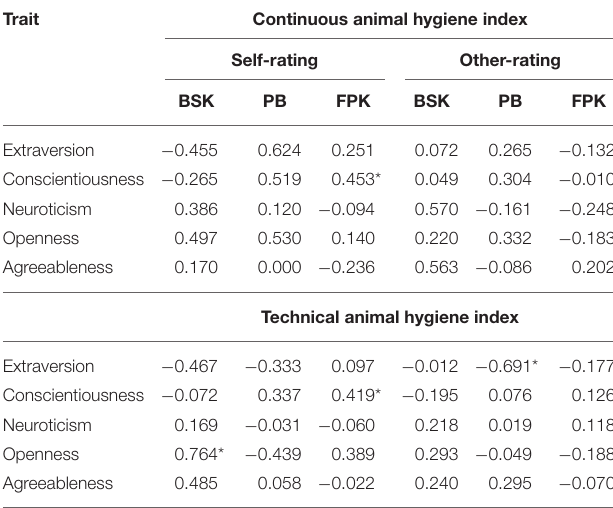
TABLE 6 | Spearman correlations ( r S, p * ≤ 0.05) of the big-five personality traits (BFI-S) by self- and other-rating with the “continuous animal hygiene index” and the “technical animal hygiene index” according to the production